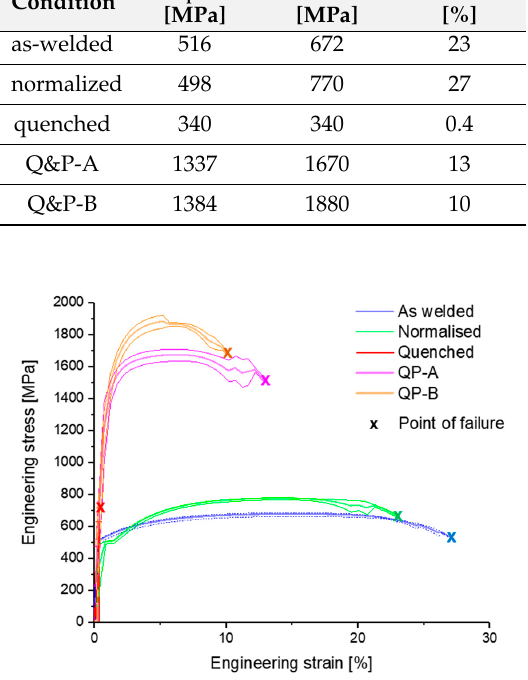
Figure 13. Average, maximum and minimum stress–strain curve of tensile tests and point of failure for different heat treatments.